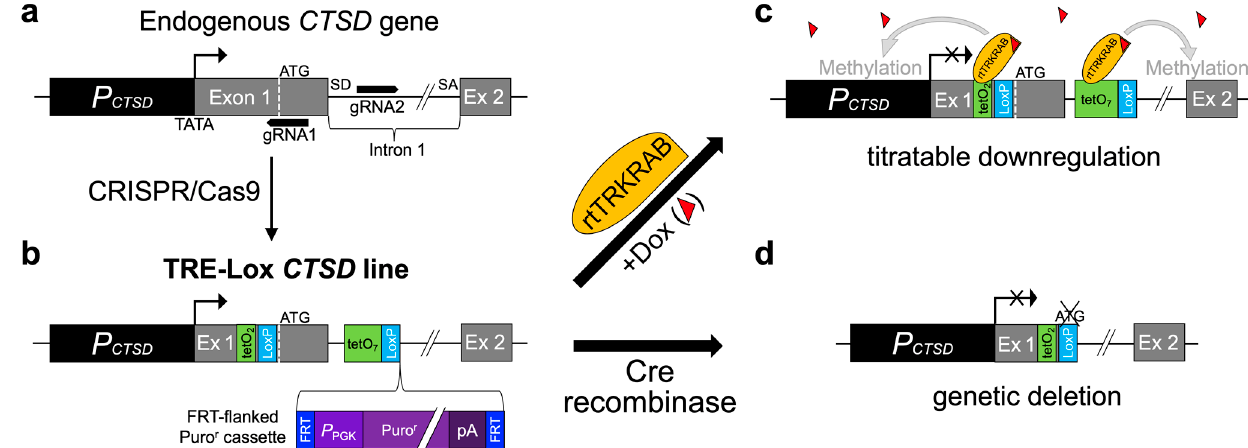
Figure 1. Overview of the design and dual-functionality of the TRE-Lox system. ( a ) Overall structure of the 5’ end of the murine cathepsin D (CatD) gene ( CTSD ) and its promoter region ( P CTSD , dark gray), indicating the relative position of the two gRNAs (black arrows) used for CRISPR/Cas9- assisted homologous recombination. Note the placement of the TATA box (TATA) very close to the main transcription start site (TSS) (right-angle arrow), the presence of the initiation codon (ATG, dashed white line) within Exon 1 (Ex 1, light gray), and the presence of a splice donor (SD) and splice acceptor (SA) flanking Intron 1 (black line). ( b ) Structure of the TRE-Lox knock-in (KI) insert, illustrating the relative positions of the two tet-operons (tetO 2 , green) and one LoxP site (LoxP, light blue) within the 5' untranslated region (5 ′ UTR) and, within Intron 1, a tetracycline response element (TRE) comprised of seven tetO repeats (tetO 7 ) and the second LoxP site. The relative placement of the puromycin resistance cassette (Puro r , purple) flanked by two FRT sites (FRT, dark blue), which is excisable by Flp recombinase, is depicted using a curly bracket. ( c ) Downregulation of CTSD via the action of rtTRKRAB acting on the TRE-Lox insert. In the presence of Dox (red triangles), rtTRKRAB binds to the tetO repeats within both the 5’UTR and Intron 1, triggering methylation of histones in a radius of 2–3 kb, thereby remodeling the chromatin and silencing the CTSD gene. ( d ) Genetic deletion of CTSD via the action of Cre recombinase on the TRE-Lox insert. The figure depicts the end result of Cre-mediated recombination of the TRE-Lox KI insert, which causes removal of the initiation codon, the first portion of the coding region of Exon 1 encoding the signal peptide of CatD, and the 5’ end of Intron 1.